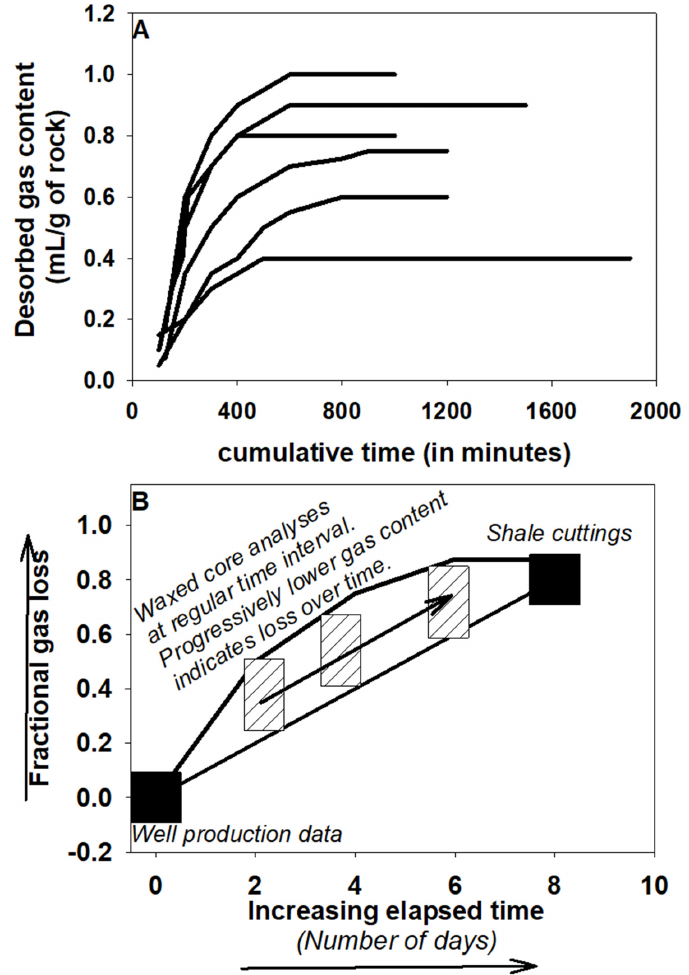
Figure 5. ( A ) Gas loss estimates by desorption using the Amoco curve fit method for shale samples as in [22]. The trends can be used to approximately estimate gas loss before a core is wax wrapped.